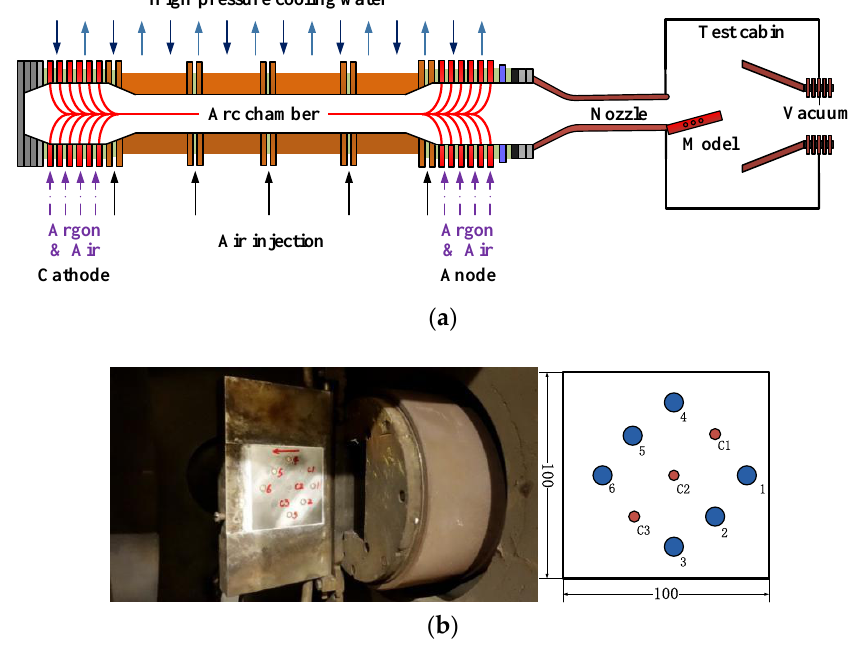
Figure 15. Schematic of the arc tunnel and test model with installed sensors. ( a ) Arc tunnel equipment diagram; ( b ) Mounted position of the sensors on the plate model.